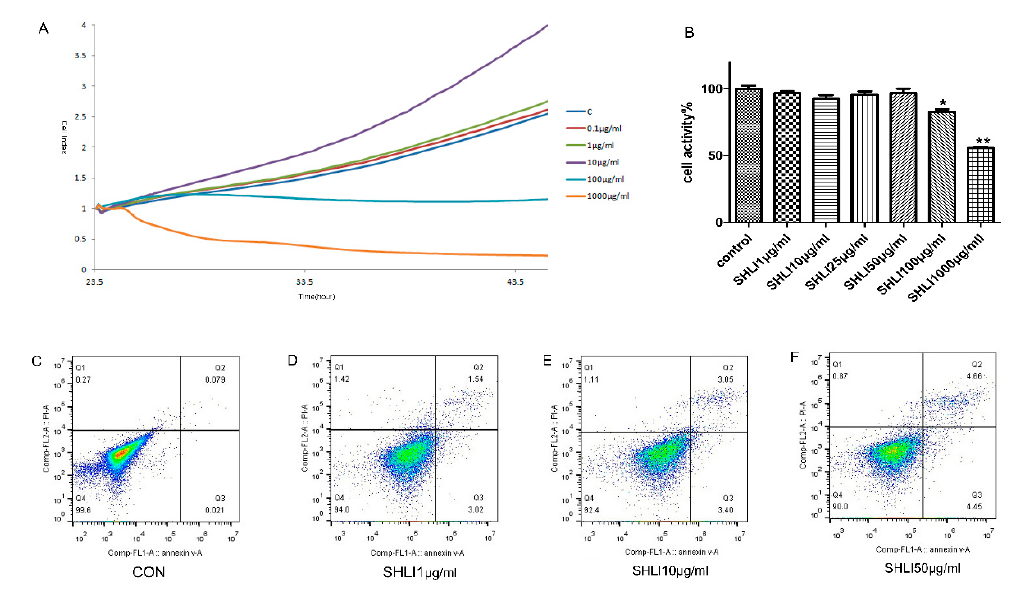
Figure 3. SHLI could not induce apoptosis of the normal Hacat cells. ( A , B ) The cell viability analysis of Hacat cell treated with different concentration of SHIL by RTCA ( A ) and Thiazolyl blue (MTT) ( B ). ( C – F ) Apoptosis rate analysis by flow cytometry.